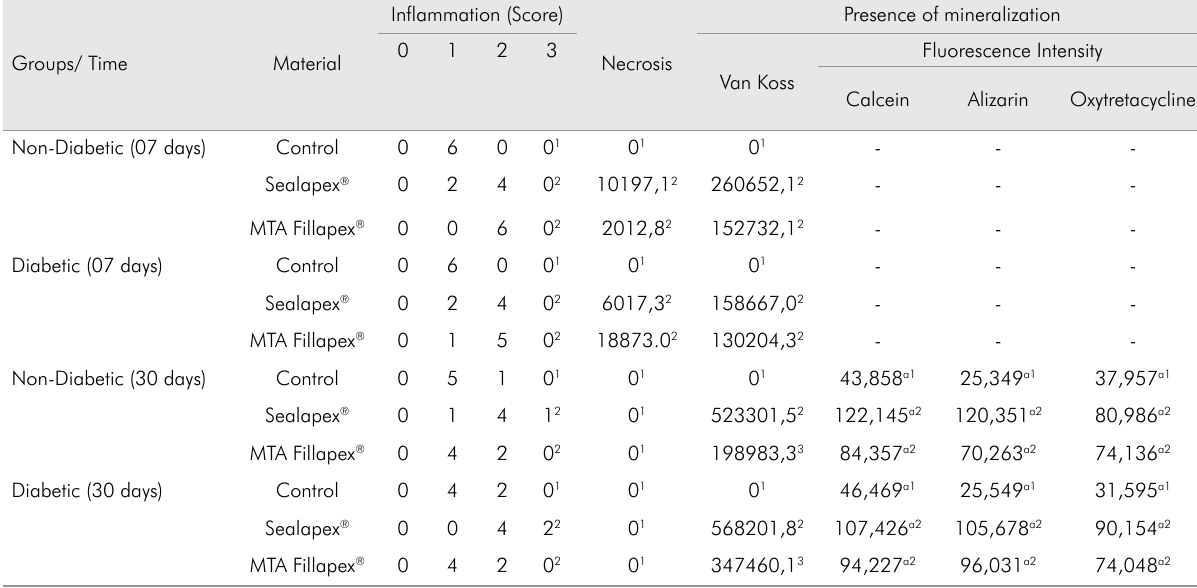
Table 1. Number of samples in each group categorized according to the inflammatory score and median of samples in each group categorized by necrosis, presence of mineralization, and fluorescence intensity.